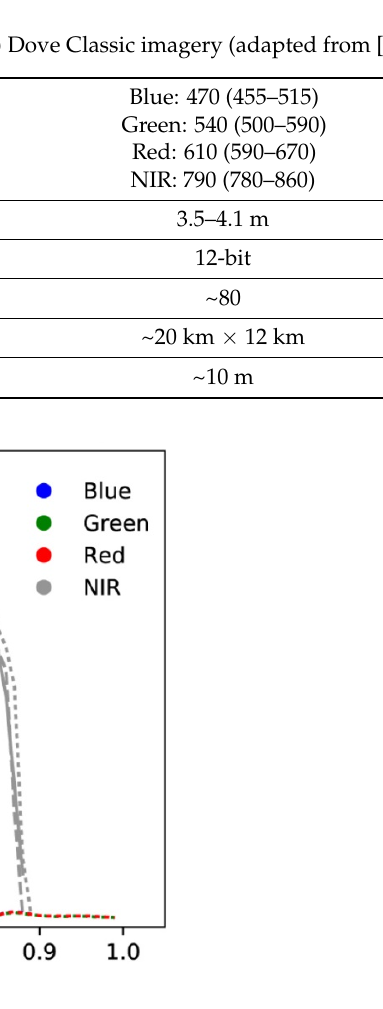
Figure 2. Relative Spectral Response (RSR) of the PlanetScope (PS) Dove four multispectral bands (adapted from [37]).